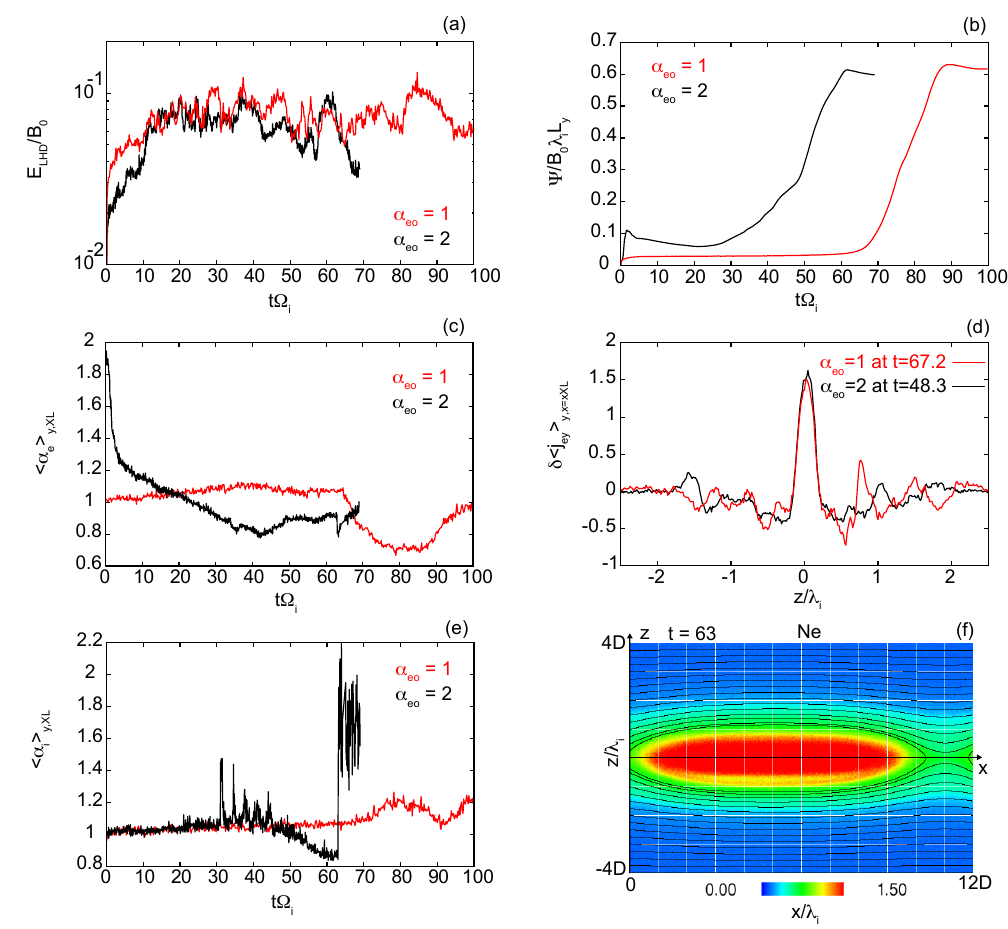
Fig. 2. Comparison between the α eo =1 and the α eo =2 cases with D =1.125 and α io =1. The red (black) lines show the results of α eo =1 (2) case, respectively. The temporal developments of (a) E LHD , (b) 9 , (c) <a e > y,XL , and (e) <α i > y,XL are shown. (d) δ<j ey > y,xXL along z at the onsets of explosive reconnection. (f) 2-D XZ contour of plasma number density (color) and the field lines (black curve) at the saturation time of t =63 from the α eo =2 case. It is found that field line reconnection fully across the current sheet is failed to occur even with the aid of the α eo effects. The electron anisotropy effects do not save the QMRT from the crisis of being not able to trigger a large-scale